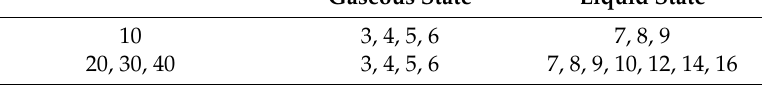
Table 1. Steady-state permeability test conditions for the same sample.